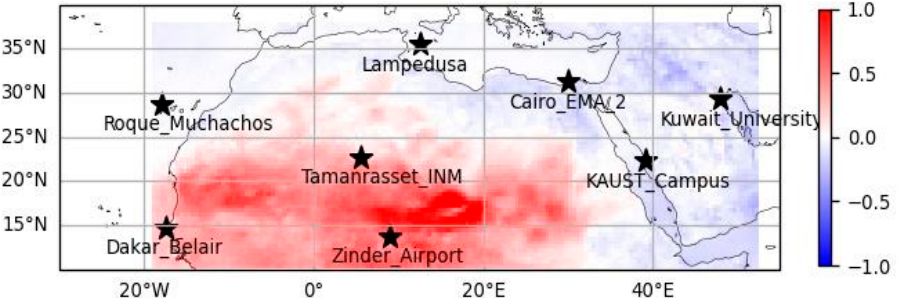
Figure 3. Annual median of the difference between CHIMERE and MODIS AOD at 550 nm for the year 2021 over the simulation domain of North Africa and the Arabian Peninsula. The stars indicate the 8 AERONET stations used for the comparisons in Figure 2.